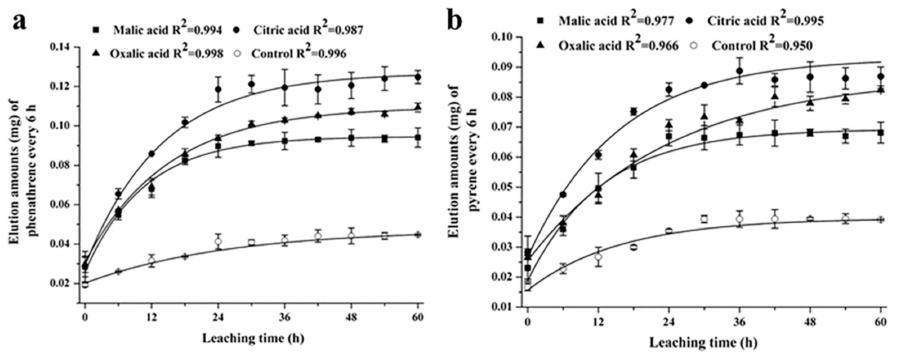
Figure 3. The concentration of ( a ) phenanthrene and ( b ) pyrene in leachate solutions from con- taminated sediment (160 mmol/L root exudates). Error bars represent the standard error (SD). (Reproduced from reference [42] with permission from Springer,